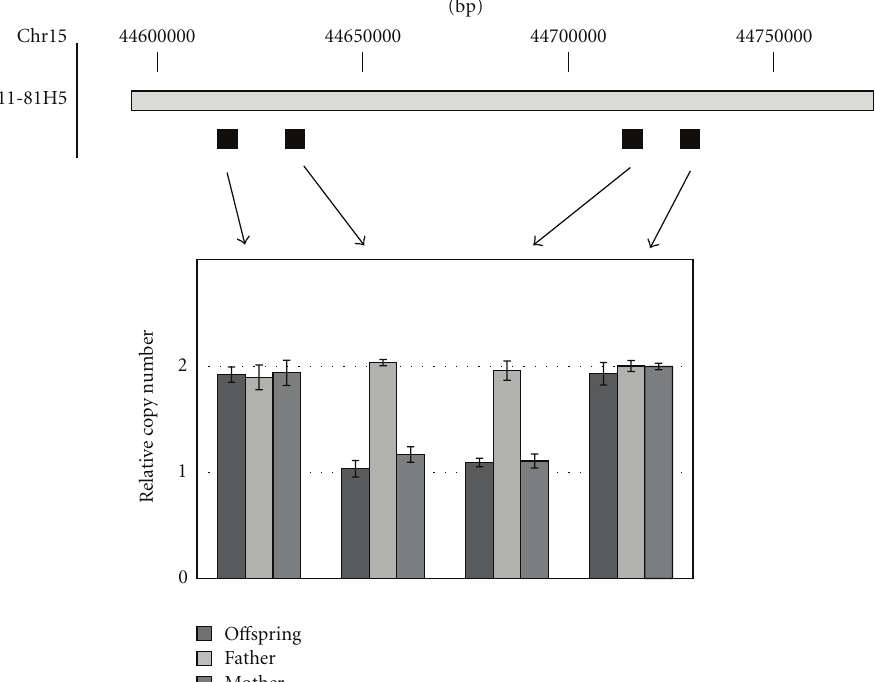
Figure 1: Characterization of a loss-type CNV detected on a BAC-clone RP11-81H5. A genome map of the RP11-81H5-containing region was obtained from the UCSC Genome Browser website. The distance (bp) from the p-terminal of chromosome 15 is shown in the uppermost part. The positions of PCR primers examined are shown by solid boxes. The experimental conditions are described more precisely in the text. The relative copy number of each site was normalized using the quantity of the amplified segment of a portion of a di ff erent chromosome (Chromosome 16) as a standard (relative copy number = 2) and was shown as mean ± SD ( n =